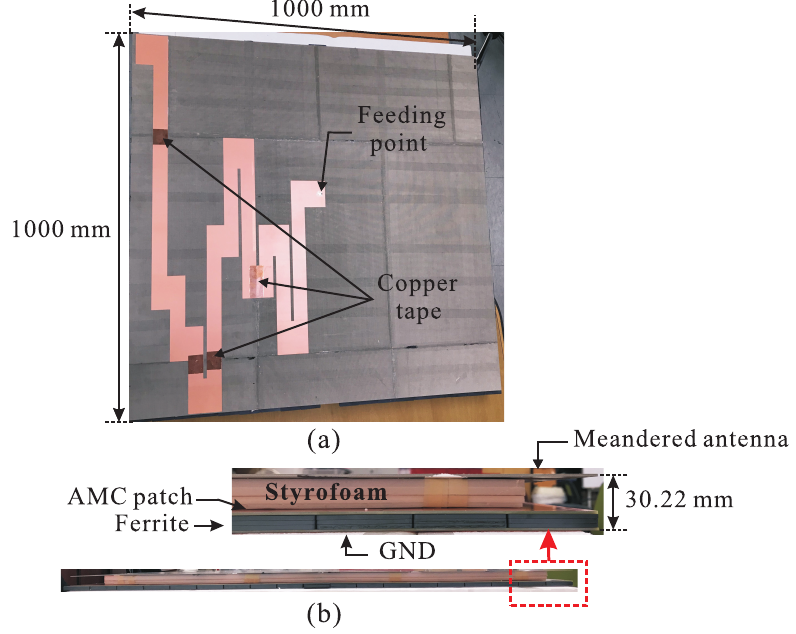
Figure 6. Photograph of the fabricated antenna with the AMC: ( a ) top-view; ( b ) side-view.